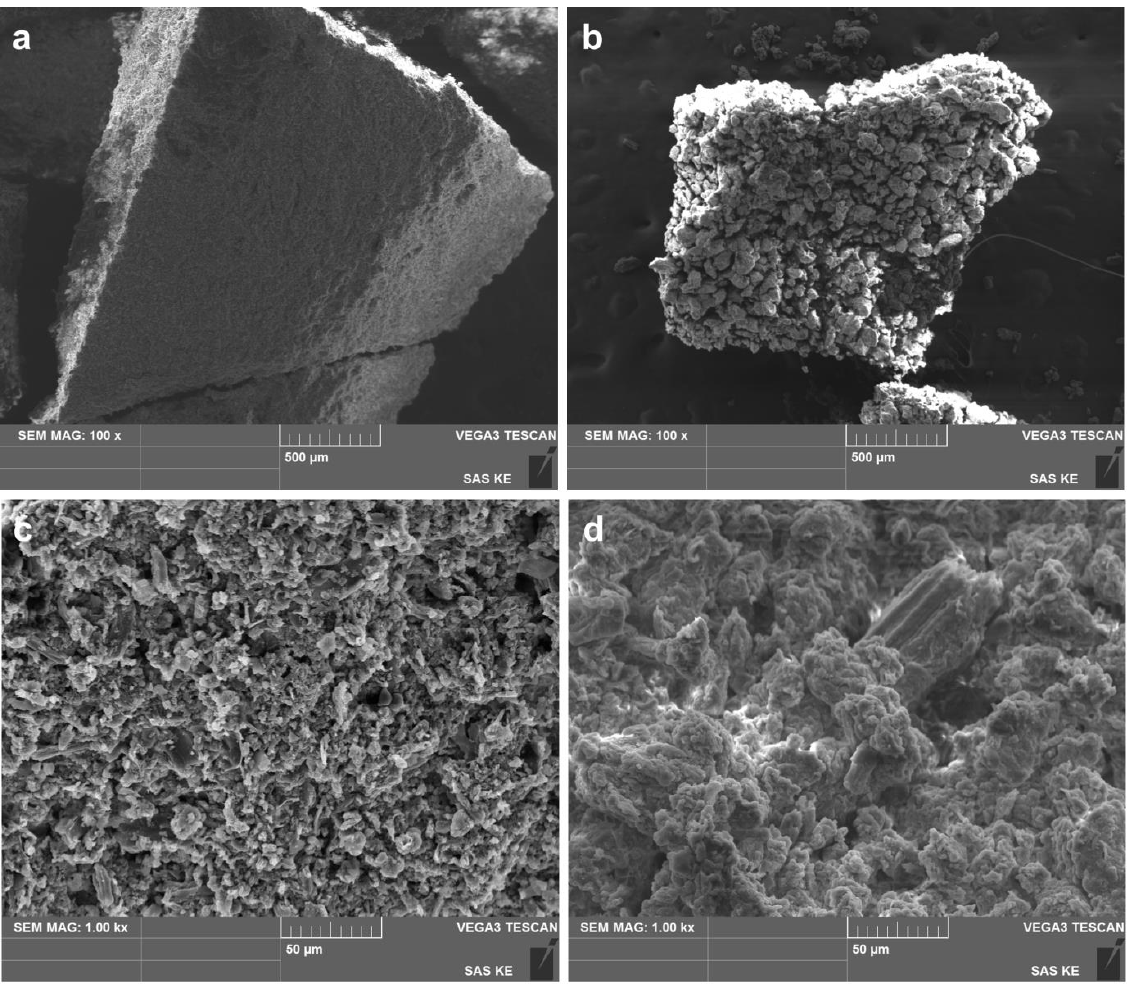
Figure 5. Scanning electron micrographs of LEV-Ag-MSW-5.95 ( a , c ) and 0.99 ( b , d ) samples taken at ( a , b ) lower, ( c , d ) higher magnification.